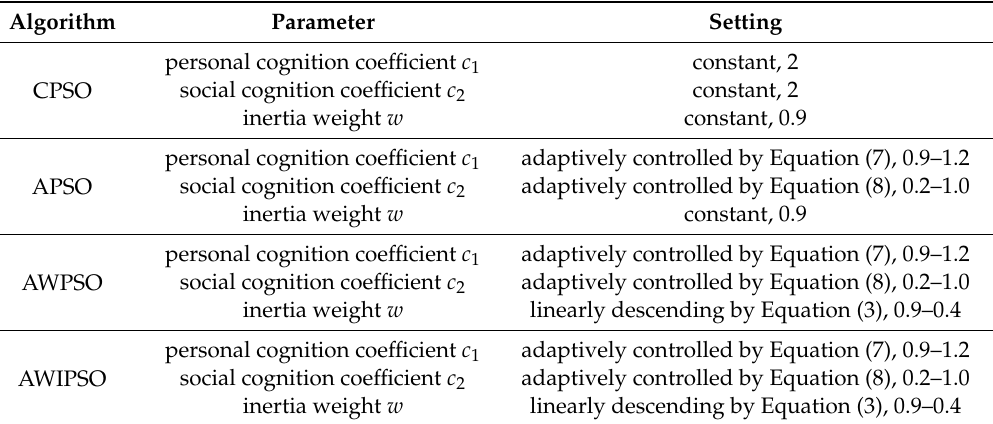
Table 1. Parameter settings for each